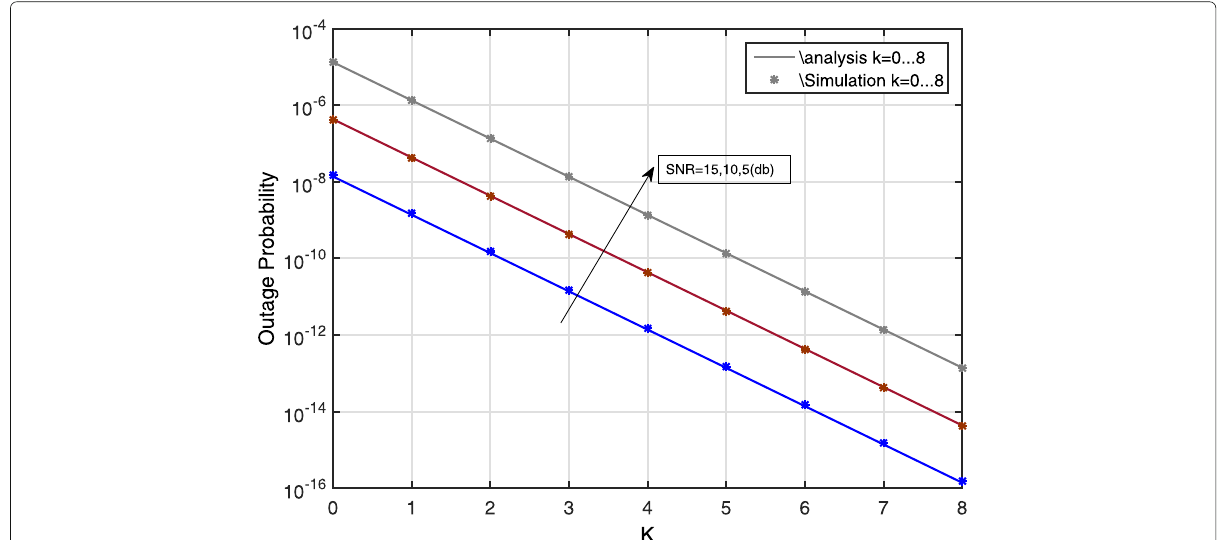
(cid:14) (cid:15) = 3, m = 3, = 0.1, p ex 1 , p ex 2 ... p ex r k d N r k